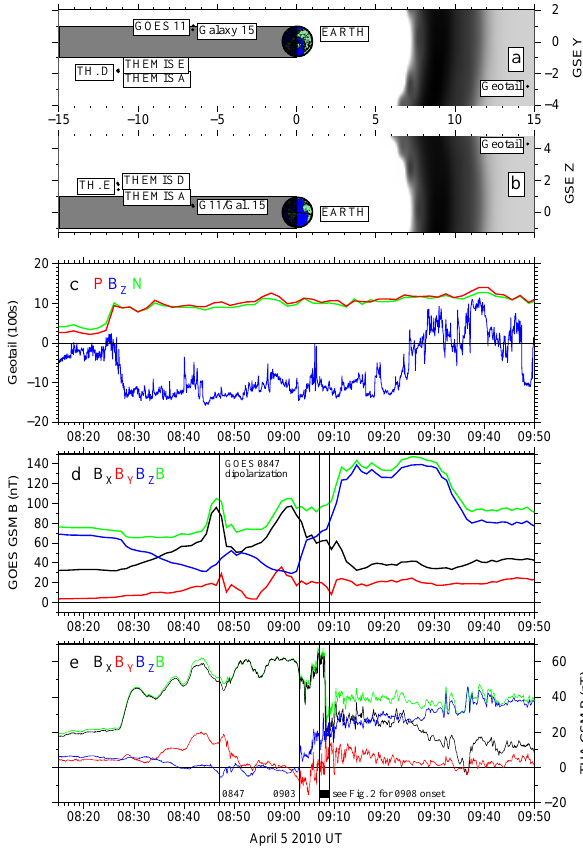
Fig. 1. Spacecraft positions and data on 5 April 2010. (a) GSE XY spacecraft positions at 08:36UT. Magnetosheath and solar wind B roughly indicated by grey shading. (b) As in (a) , in GSE XZ coordi- nates. (c) Geotail solar wind values (100s delay) of GSM B Z in nT (blue), dynamic pressure P in nPa (red), and proton density in cm 3 (green). (d) GOES 11 magnetic field. “Overdipolarization” of the B Z component above usual geosynchronous values lasts from 09:10 to 09:35UT. (e) THEMIS A magnetic field in GSM coordinates.